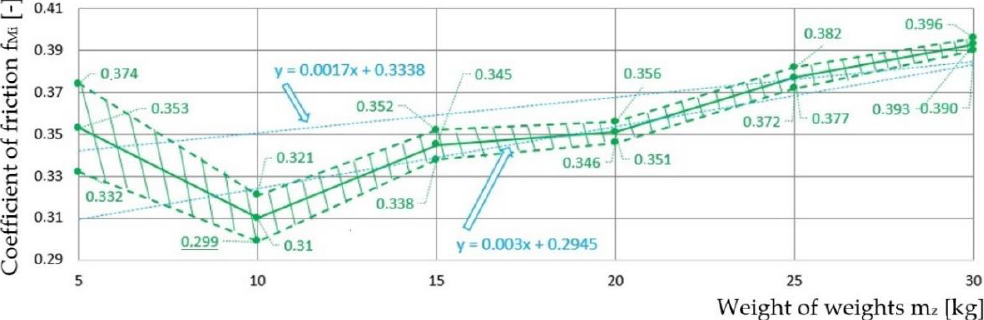
Figure 6. Laboratory-derived friction coefficient values for a 10-mm diameter cable and a groove surface contaminated with oil.